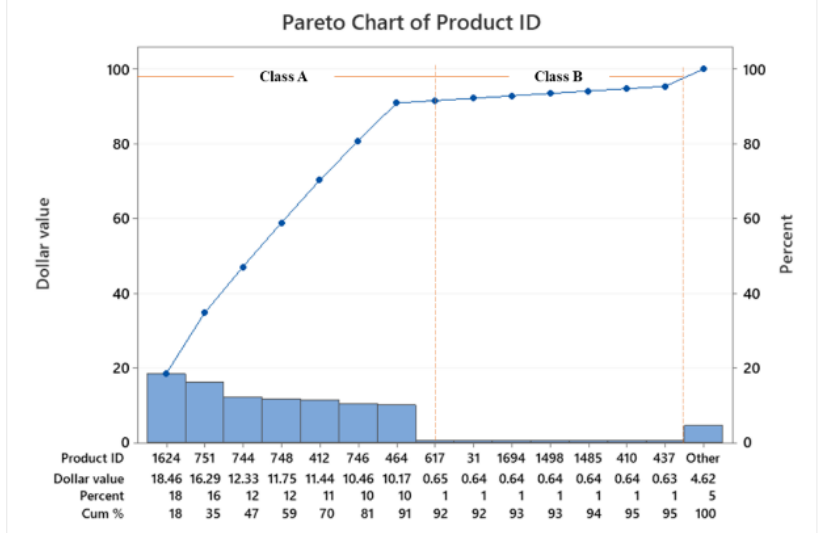
Figure 4: Pareto Chart of Demand for Period 2019 until August, 2020